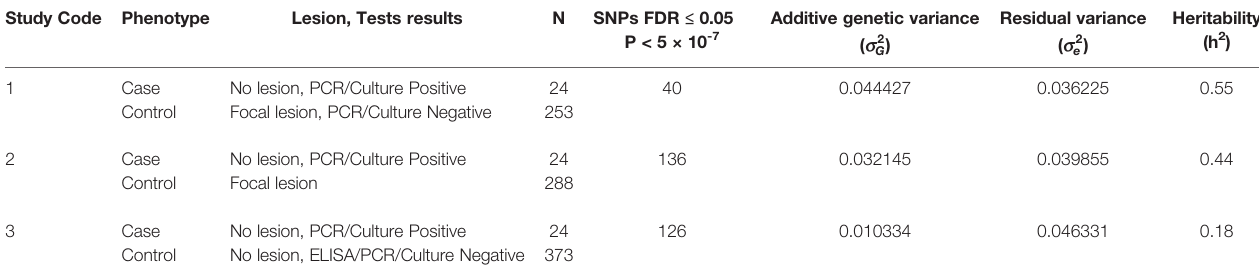
TABLE 1 | Number (N) of cases and controls, variance components, standard errors (SE), and h 2